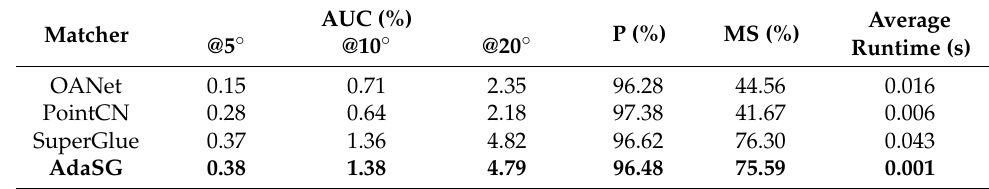
Table 2. Indoor Experiment on the Scannet dataset.